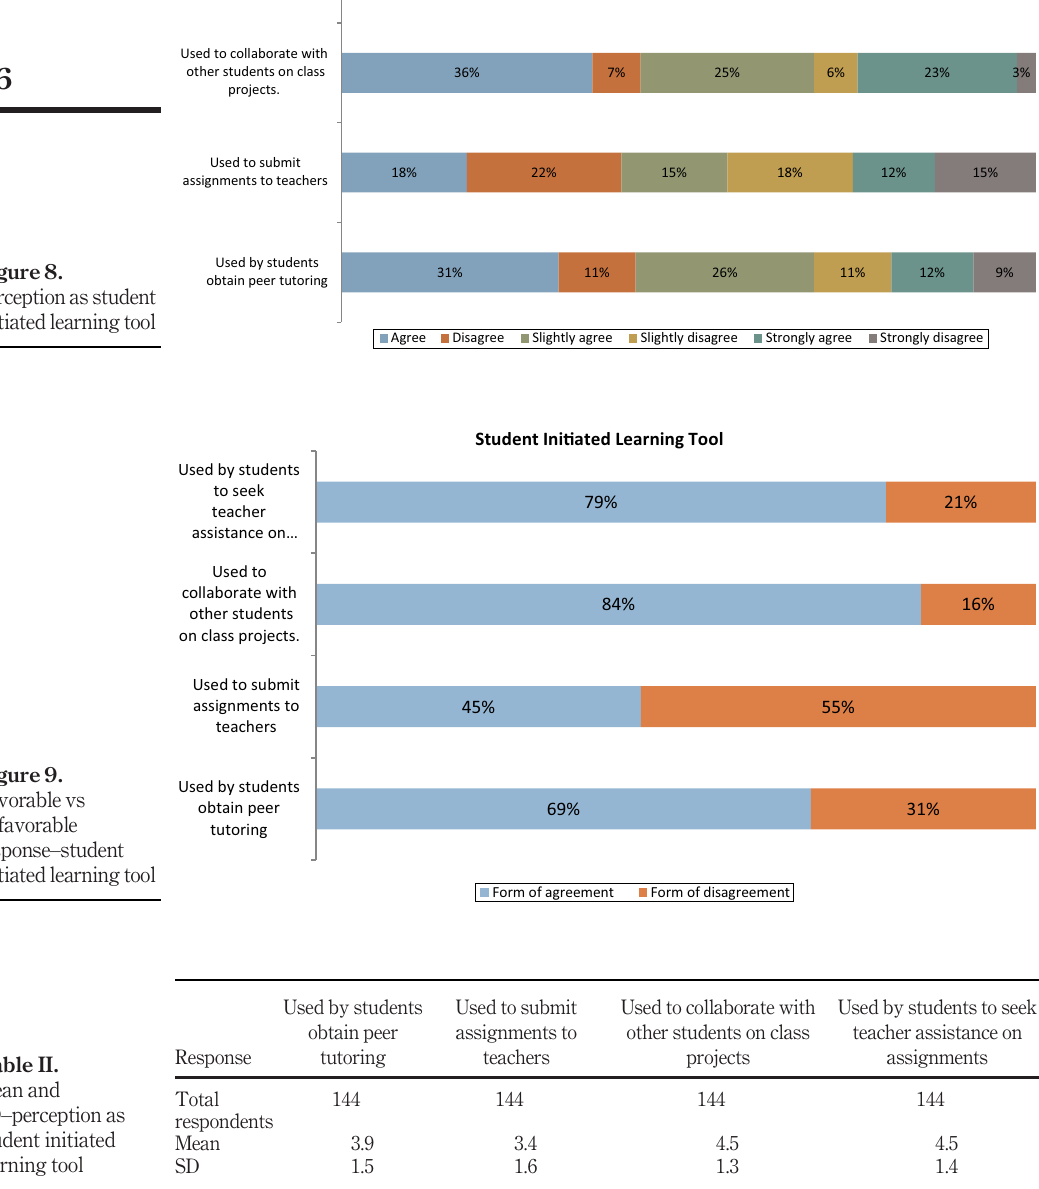
Table II. Mean and SD – perception as student initiated learning